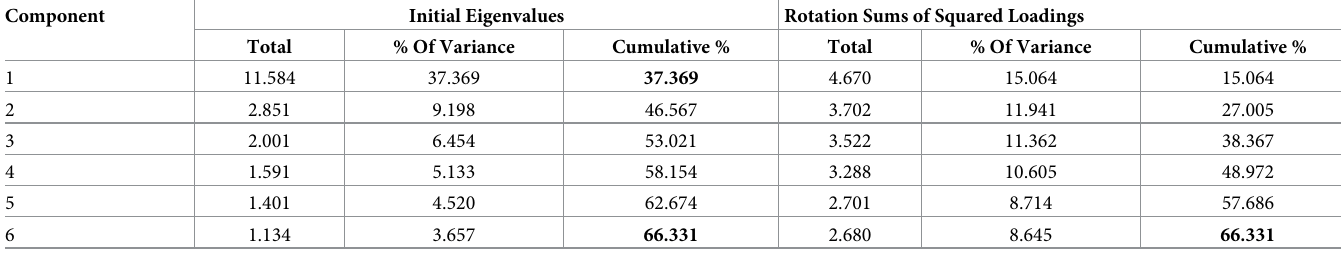
Table 6. Total variance explained.